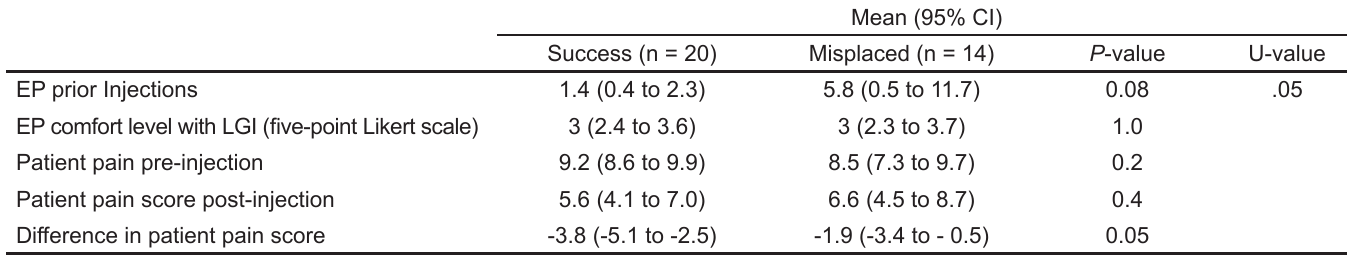
Table 1. Emergency physician measures on landmark-guided joint injections and patient measures on